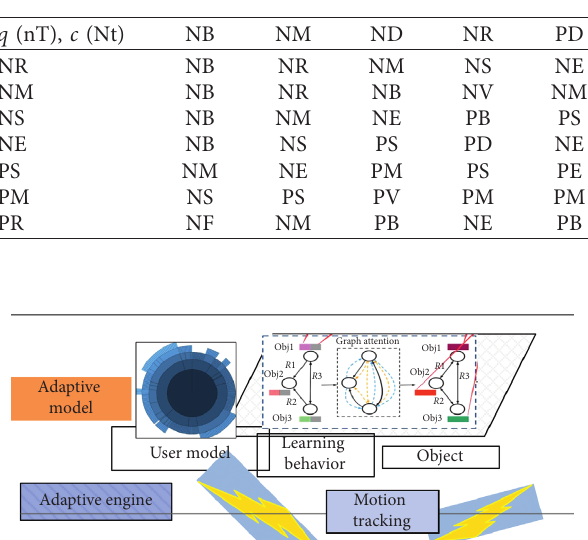
Figure 1: Structure diagram of control system based on the adaptive object model. Table 1: Performance measurement described by language variables.